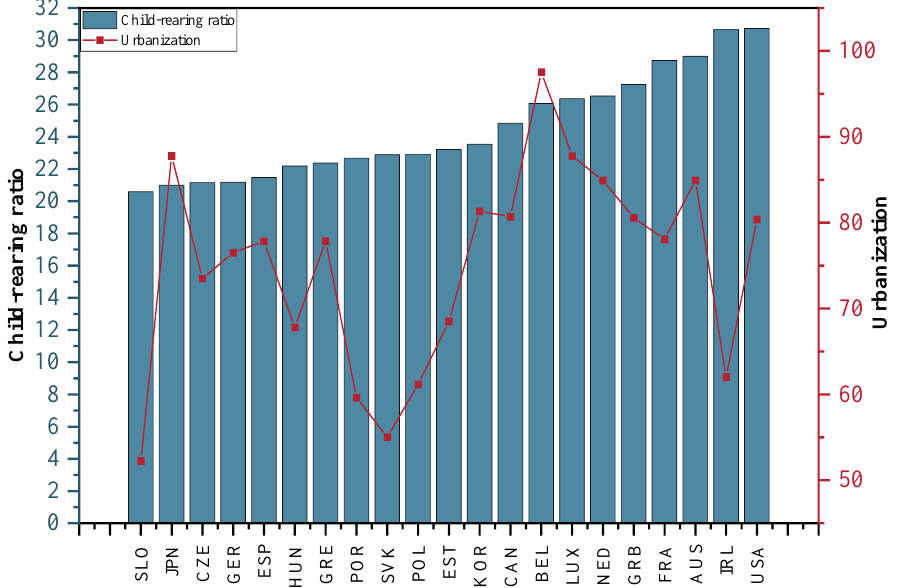
Figure 10. Average urbanization rate and child-rearing ratio in the selected OECD countries, 2001 – 2015.